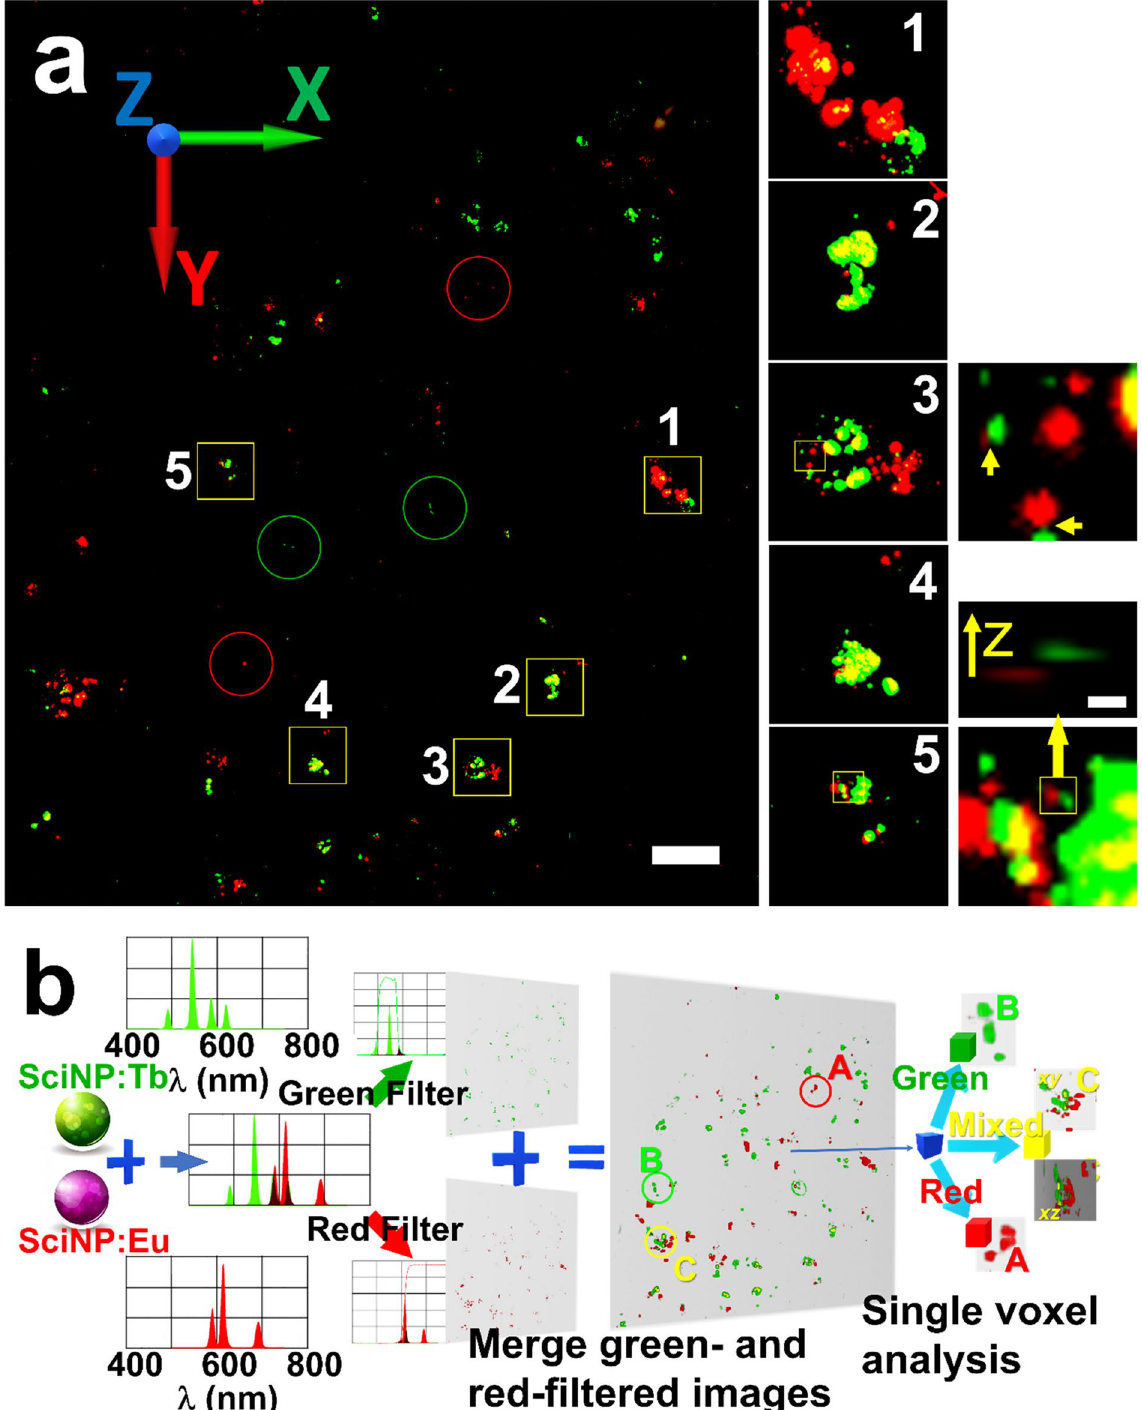
Figure 6. (a ) Fused micrograph of two MAXWELL images taken with red or green filters, showing HCT-116 cells loaded with NaGdF 4 :Eu (red) and NaGdF 4 :Tb (green) SciNPs. Red and green circles mark those SciNPs emitting only red or green light. The yellow squares mark regions of mixed SciNPs (yellow). Zoomed-in images are shown on the right of ( a ). ( b ) Procedure to analyze and identify the color of each voxel of the merged 3D volume, a ), with the emission spectra of red and green SciNPs. The voxels of strong green and red emission intensity are colored in yellow. Scale bar: ( a ) 50 µm; inset) 1